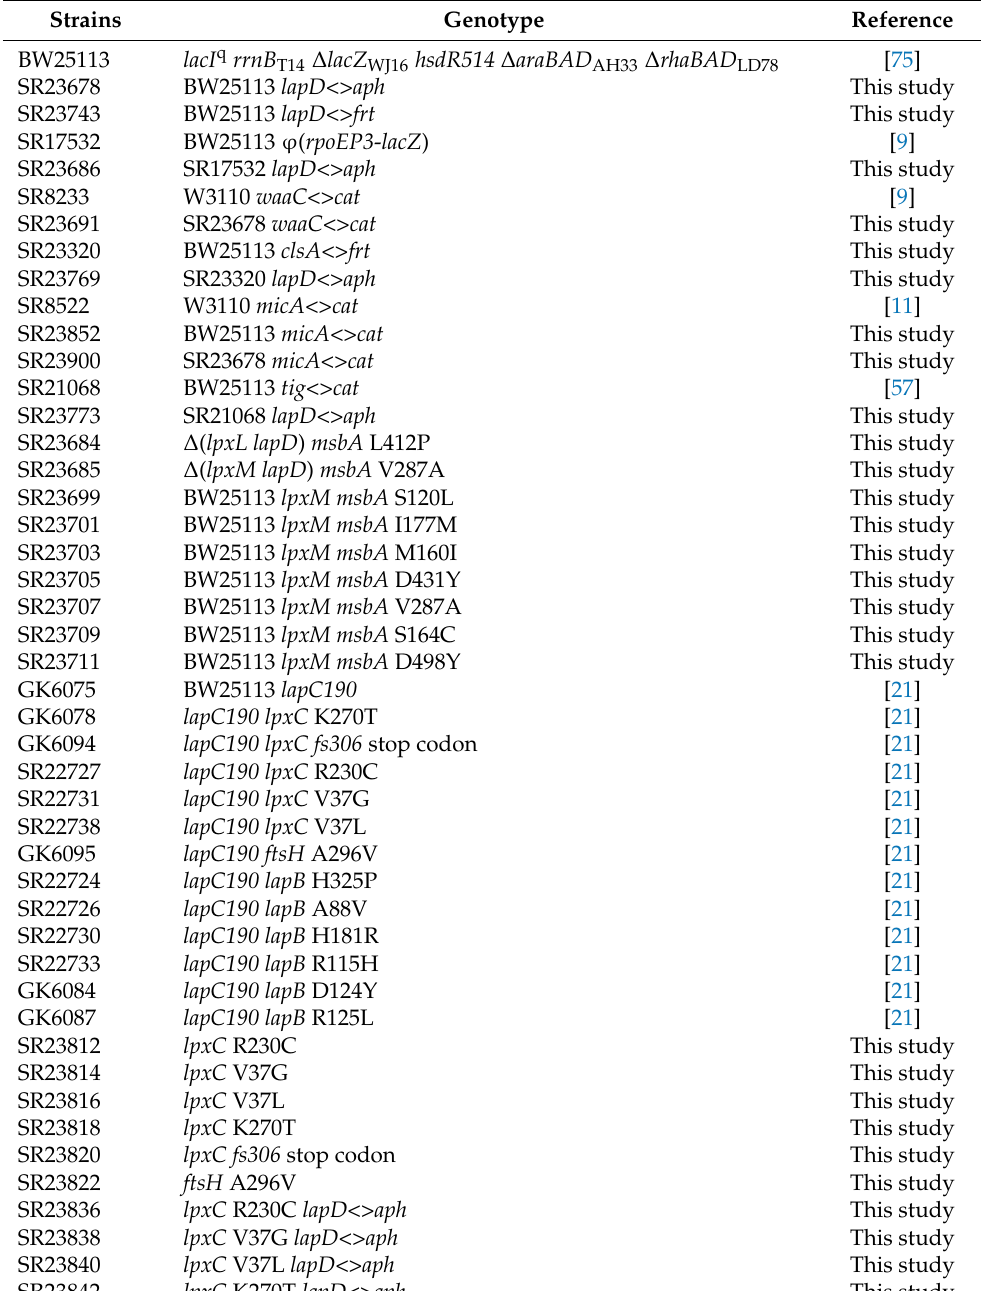
recombinase-encoding plasmid pKD46. The aph cassette was removed using the plasmid pCP20 expressing FLP recombinase at either 30 ◦ C or 33 ◦ C. Isogenic multiple deletion 30 or 33 ◦ C. Table 5. Bacterial strains and plasmids used in this study. Strains Genotype